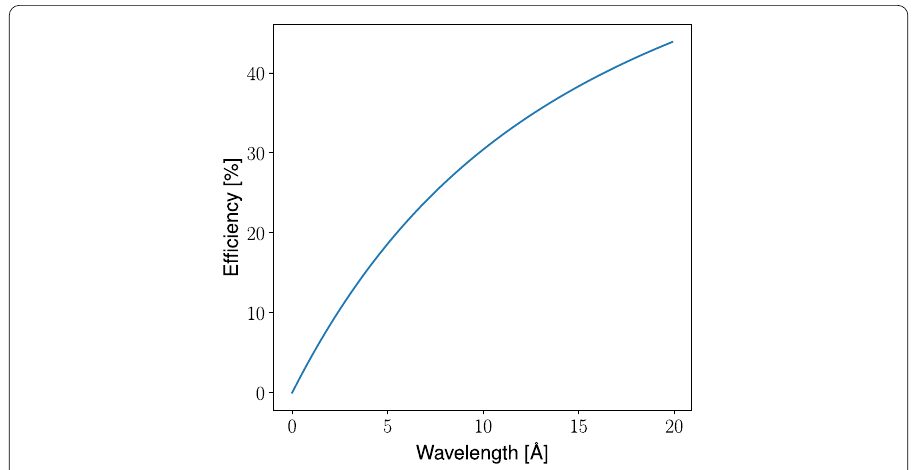
Figure 4 Efficiency of boron coating used as a function of wavelength from [45]